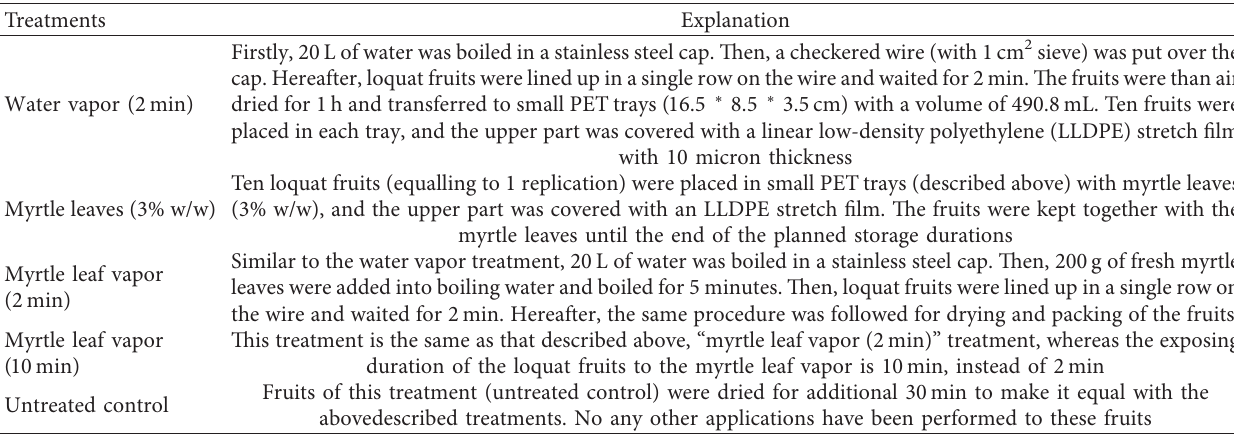
Table 1: Detailed explanations of the treatments. Treatments